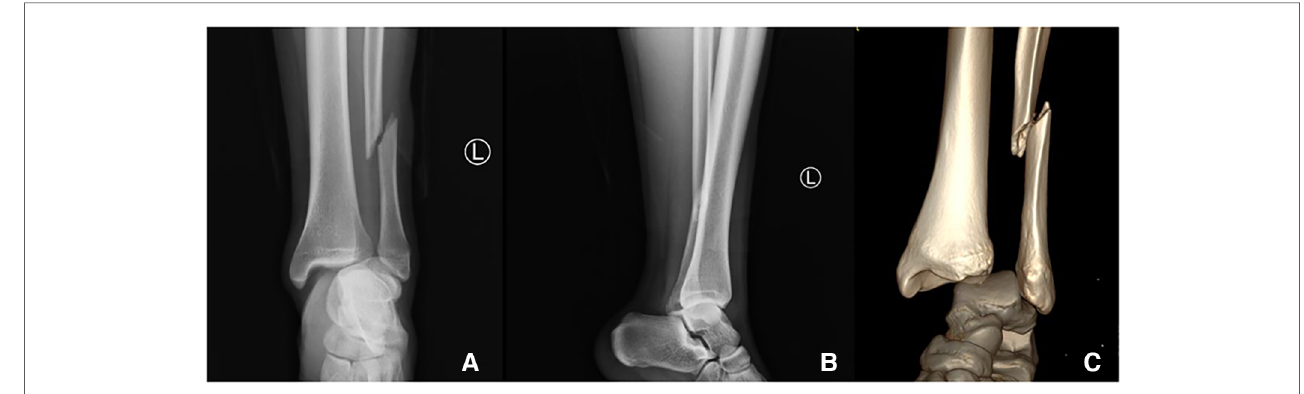
( Figure 2 ). Dynamic ultrasonography indicated the presence of an